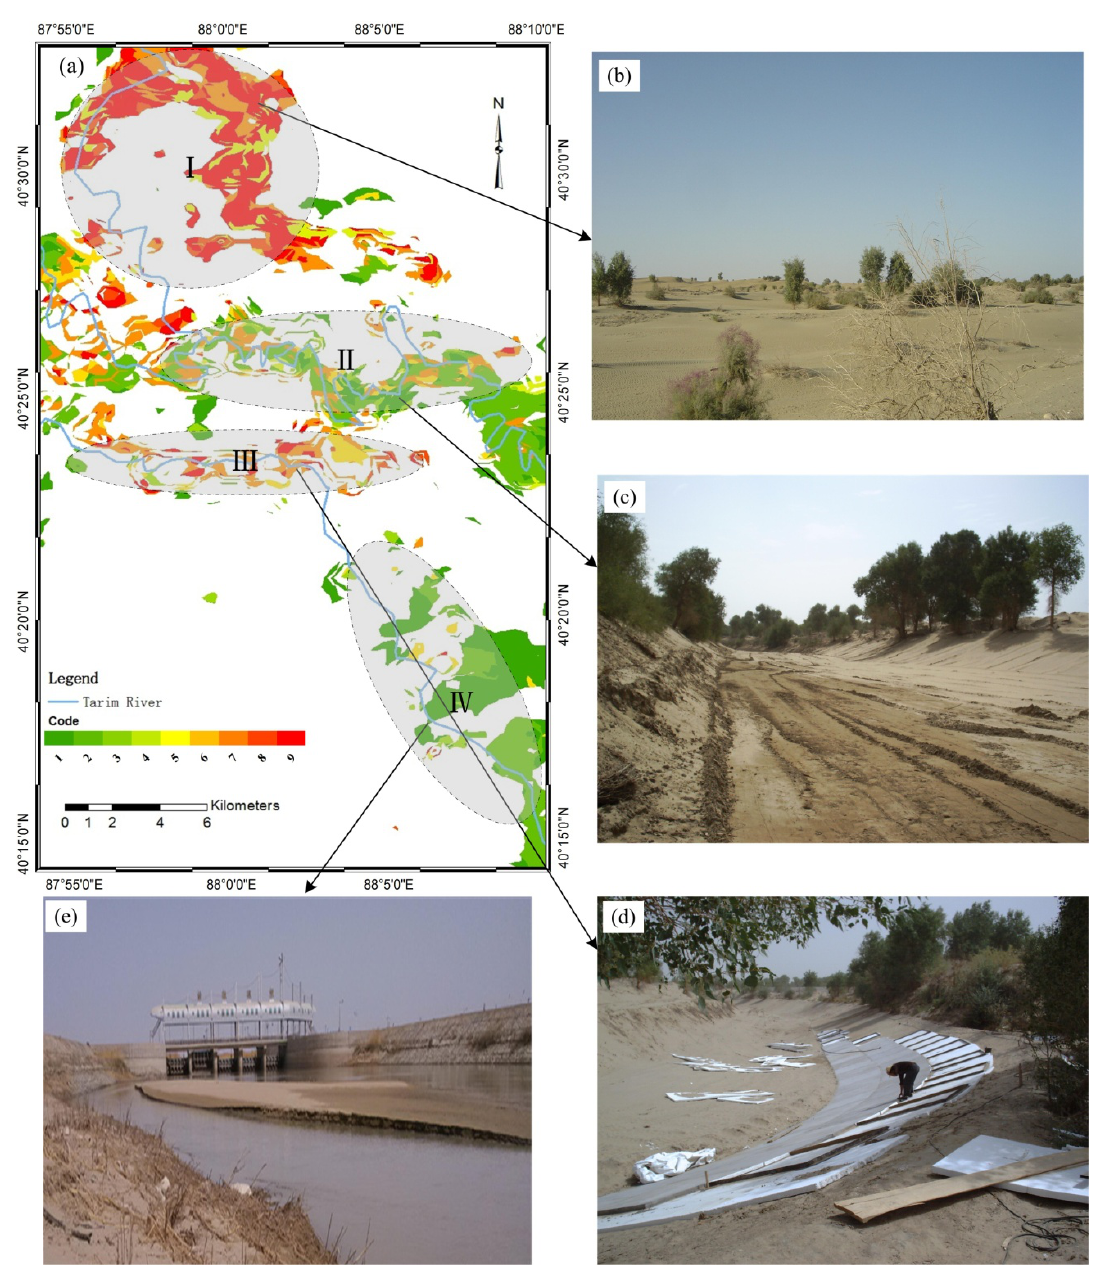
Figure 7. ( a ) Change trajectories for four districts; ( b ) dried riverbed after river diversion; ( c ) bent-to-straight river channel; ( d ) revetment in the riverbank; ( e ) ecological